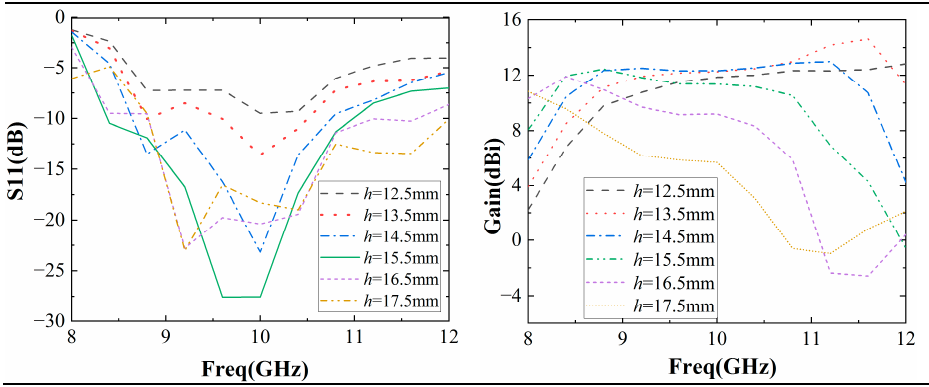
Figure 12. Simulation of F-P resonator antenna S11 and gain as a function of h .